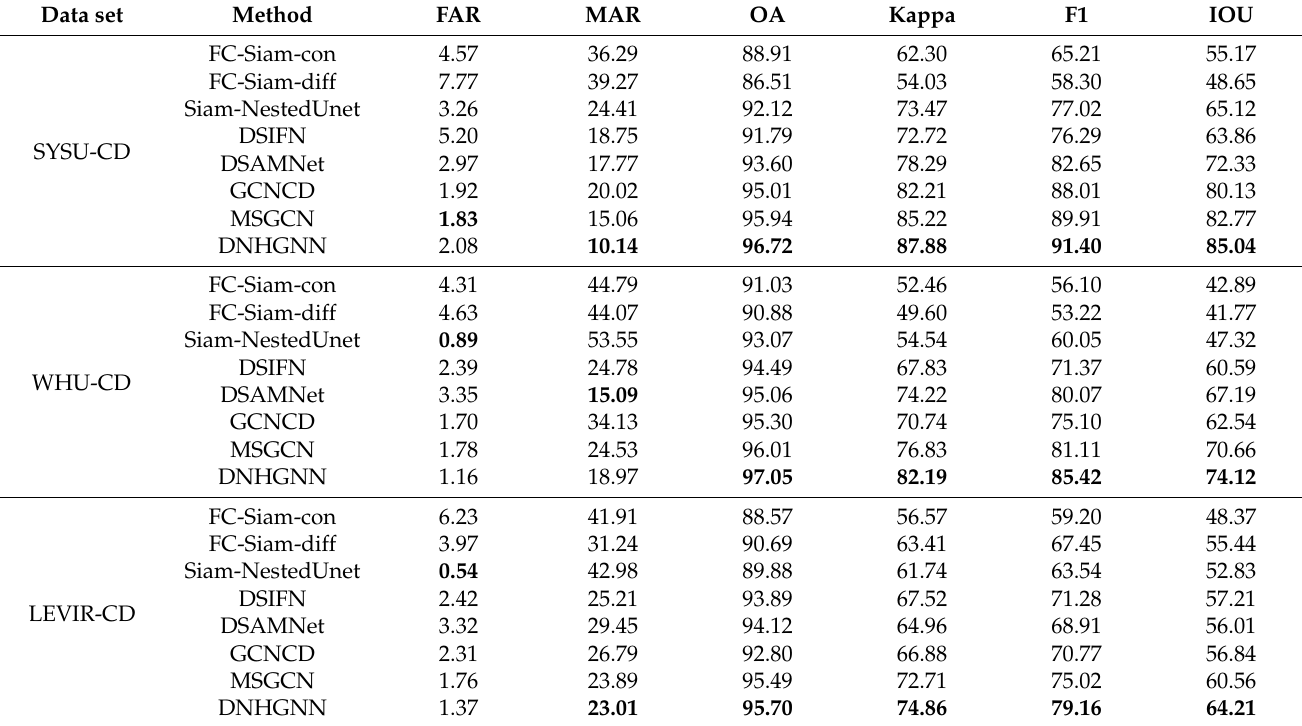
Table 1. Quantitative accuracy results for different methods on the optical data sets (%). Data